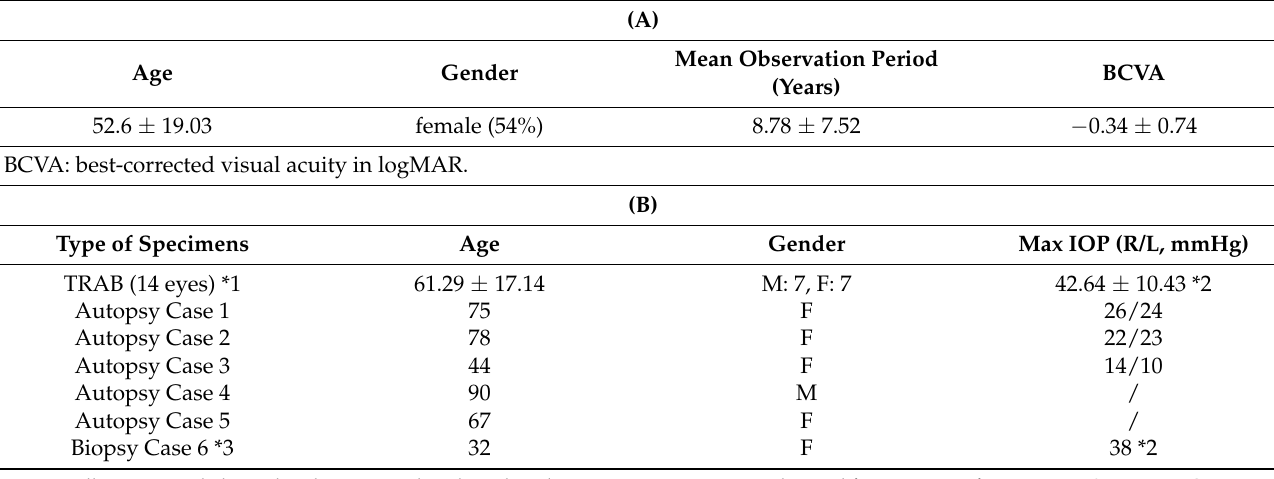
Table 1. ( A ) Patients in the clinical and pathological studies ( n = 57 patients); ( B ) Patients in the pathological